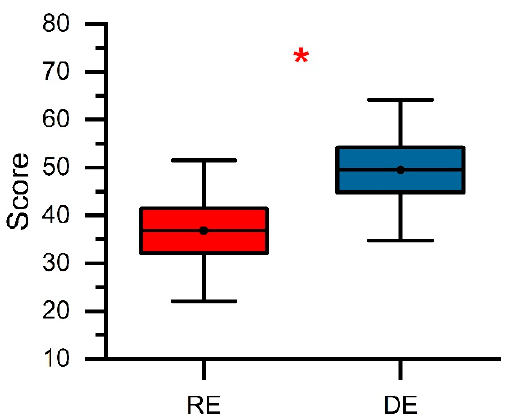
Figure 6. The total mood disturbance (TMD) for the RE and DE. Interpretation: red (*) indicates p < 0.05.